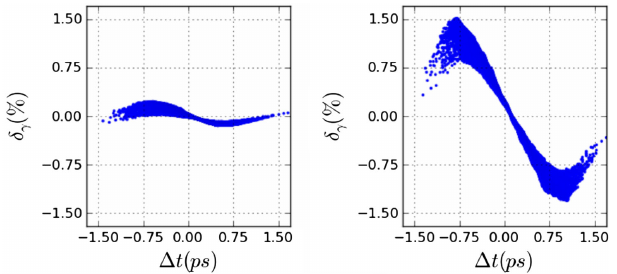
FIG. 6. Longitudinal phase spaces at 12 (left) and 110 cm (right) of the linac compressor in Fig. 4. The left phase space corresponding to energy chirp 1 =h ¼ − 120 mm is recorded downstream of the photocathode rf gun, and the right phase space corresponding to energy chirp 1 =h ¼ − 20 mm is recorded upstream of the first matching quadrupole magnet (i.e., qD 6 ). Bunch charge in the simulation is 50 pC. We focus the bunch to strengthen the space charge forces and then to increase the energy chirp from − 0 . 25% = ps ( 1 =h ¼ − 120 mm) to − 1 . 5% = ps ( 1 =h ¼ − 20 mm). In these plots, particles located at Δ t > 0 correspond to the tail particles of the